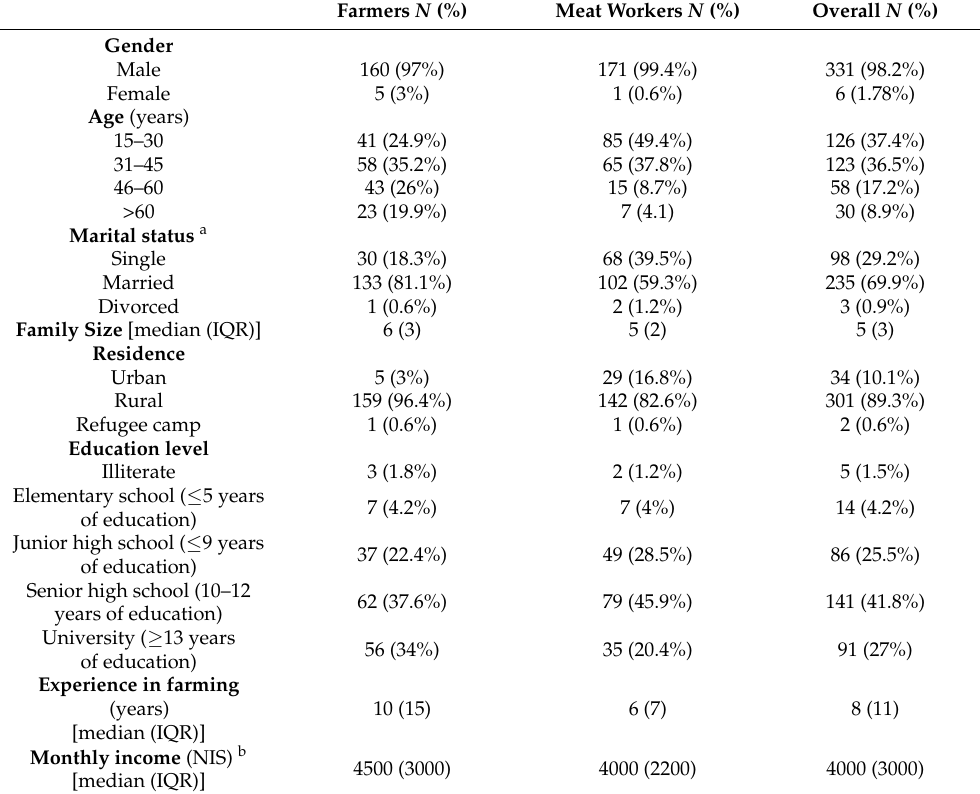
Table 1. Stratified the sociodemographic characteristics of the broiler workers surveyed based on workers’